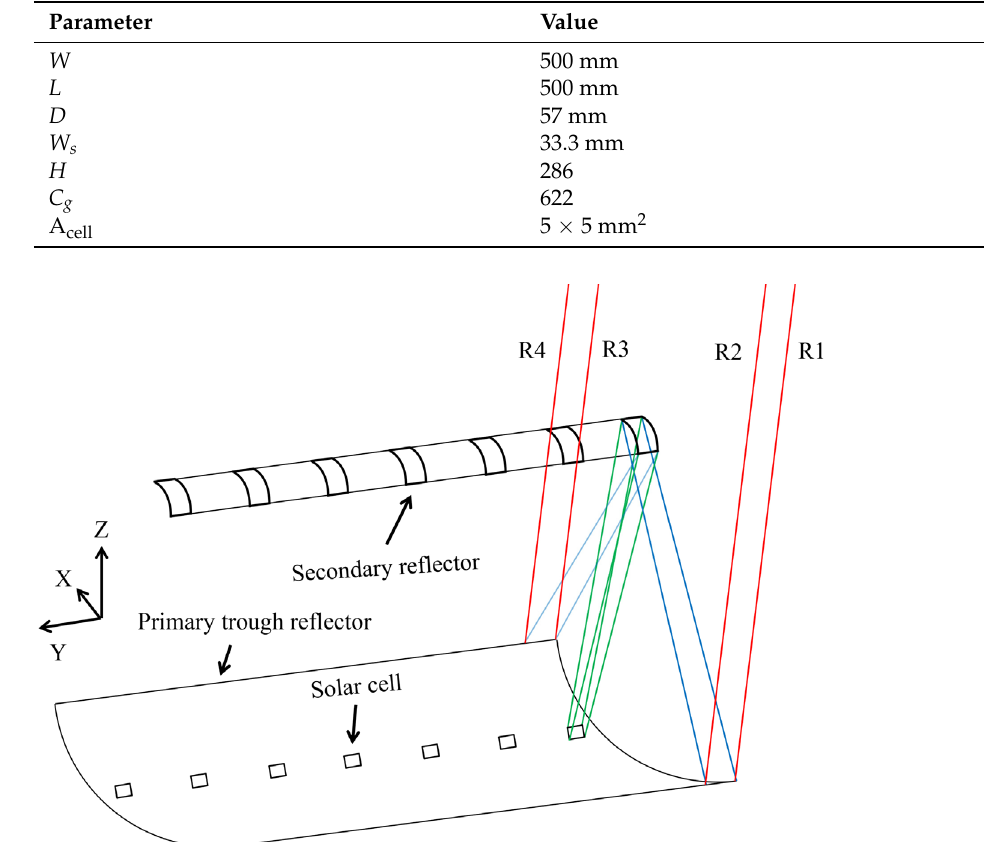
Figure 3. Three-dimensional schematic diagram of the CPV system depicting the rays from source to the receiver.